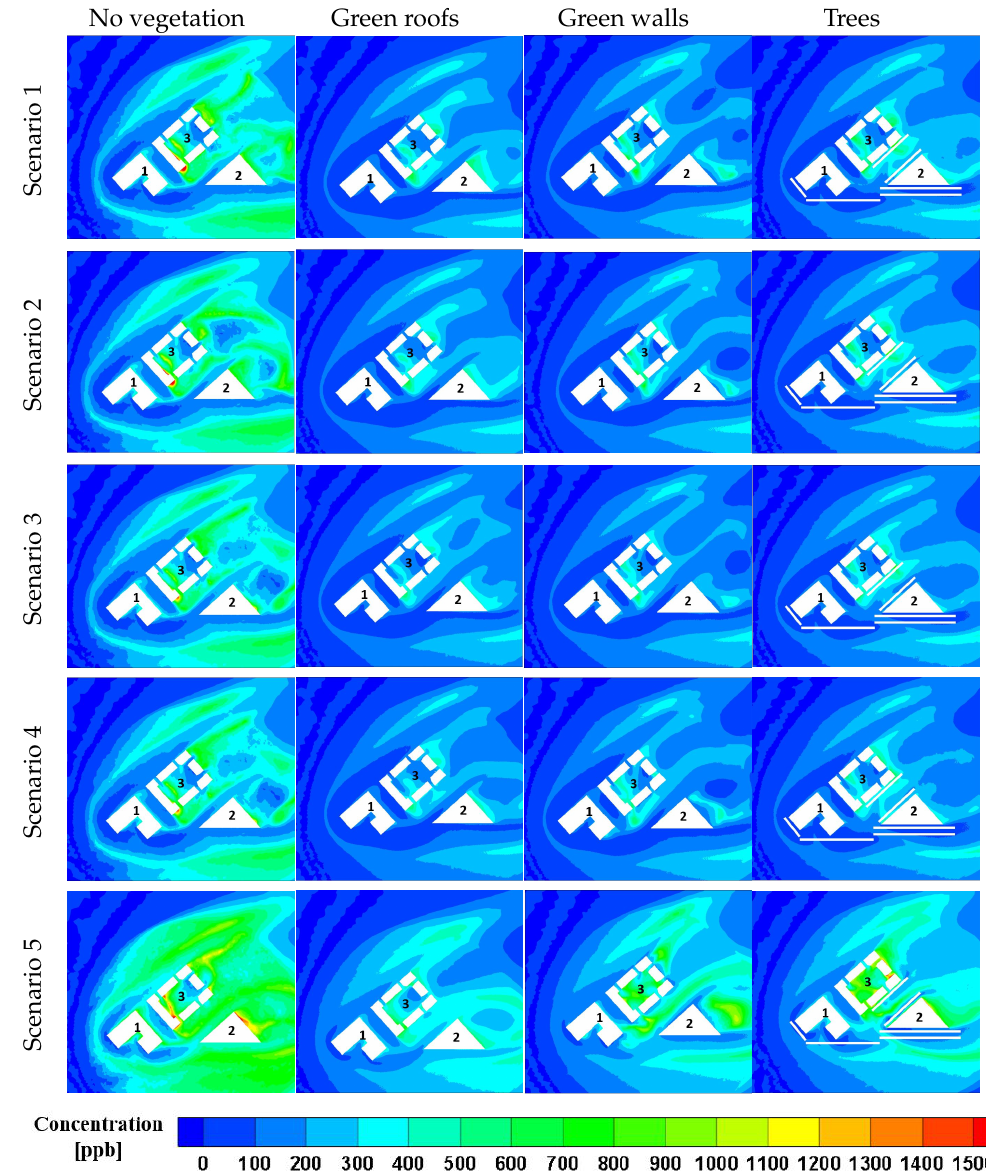
Figure 8. Contours of pollutant concentration at the pedestrian